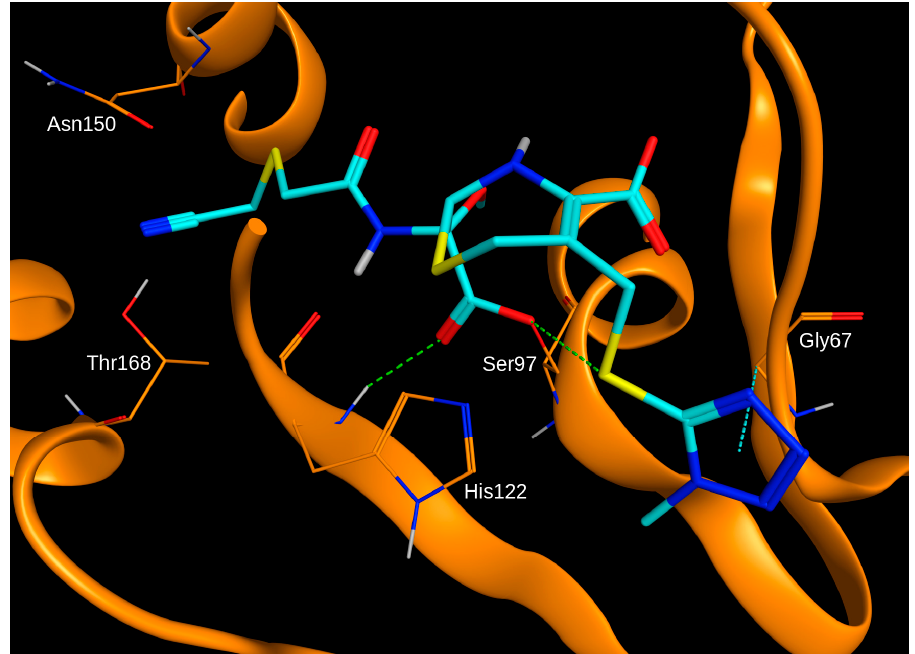
Figure 3. Binding mode of cefmetazole (carbon atoms in cyan) in ClpP obtained by molecular docking into Protein Data Bank (PDB) ID 2FZS using GOLD with the compound covalently attached to the hydroxyl oxygen of Ser97. Hydrogen bonds and C–H–pi interactions are indicated as green and cyan dashed lines, respectively.